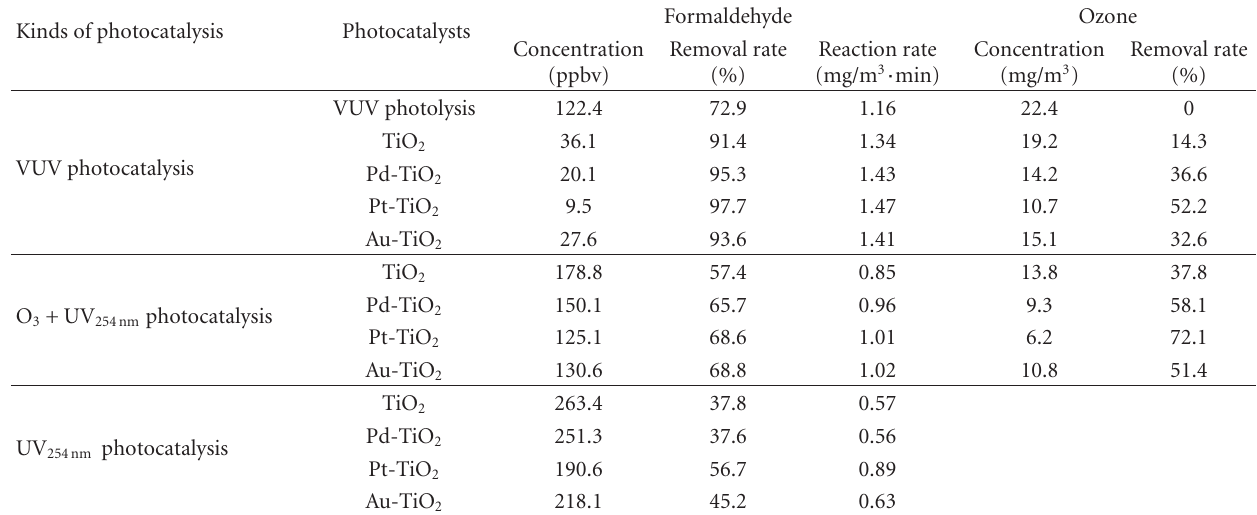
Table 1: The outlet concentration and removal rates of HCHO and O 3 , and reaction rates of HCHO in the 35 h VUV, O 3 +UV 254nm , and UV 254nm photocatalysis, respectively.